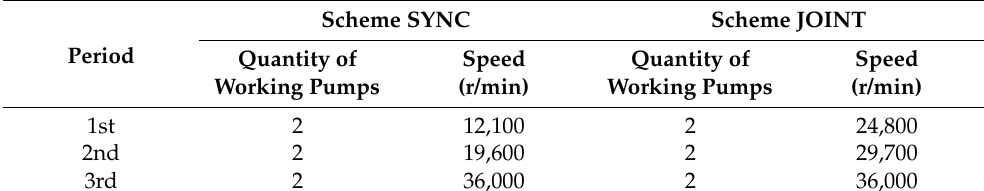
Table 7. Speed comparison between Scheme SYNC and Scheme JOINT.